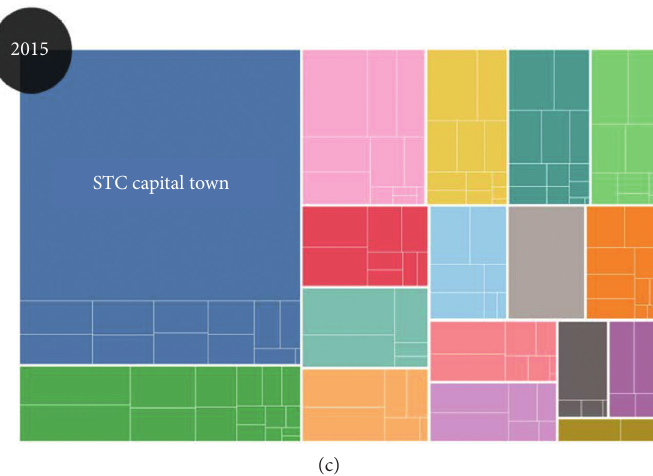
Figure 5: Cross-census comparison between (a) 1888, (b) 1960, and (c) 2015. The size of the complete chart for each year represents the total population in the whole municipality. Each settlement corresponds to a minor box, whose size depends on its relative population. The boxes with the same color are part of the same